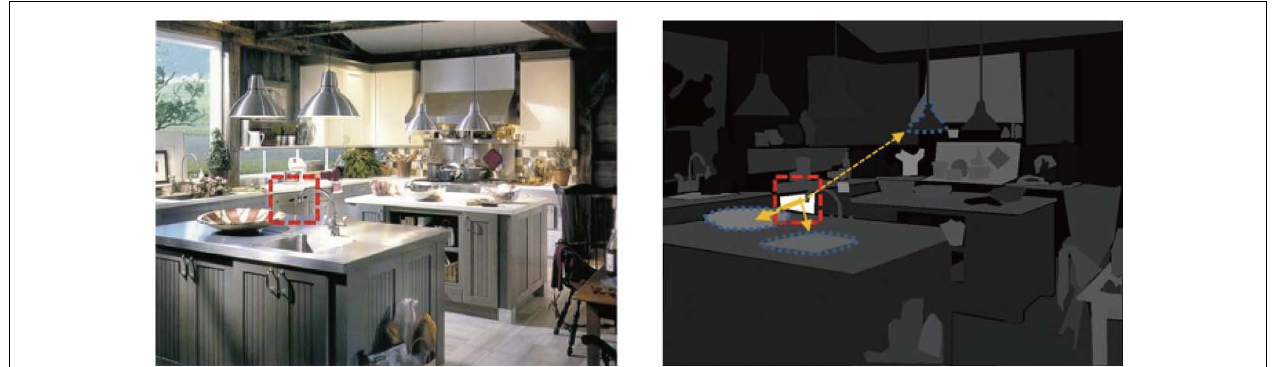
FIGURE 6 |An illustration of a semantic saliency map in an inspection task, as proposed by Hwang etal. (2011). Left: the original scene. Right: The semantic saliency map based on the currently fixated object labeled “dishwasher.”The luminance of each object indicates how semantically similar it is to the dishwasher, as quantified by the corresponding LSA cosine